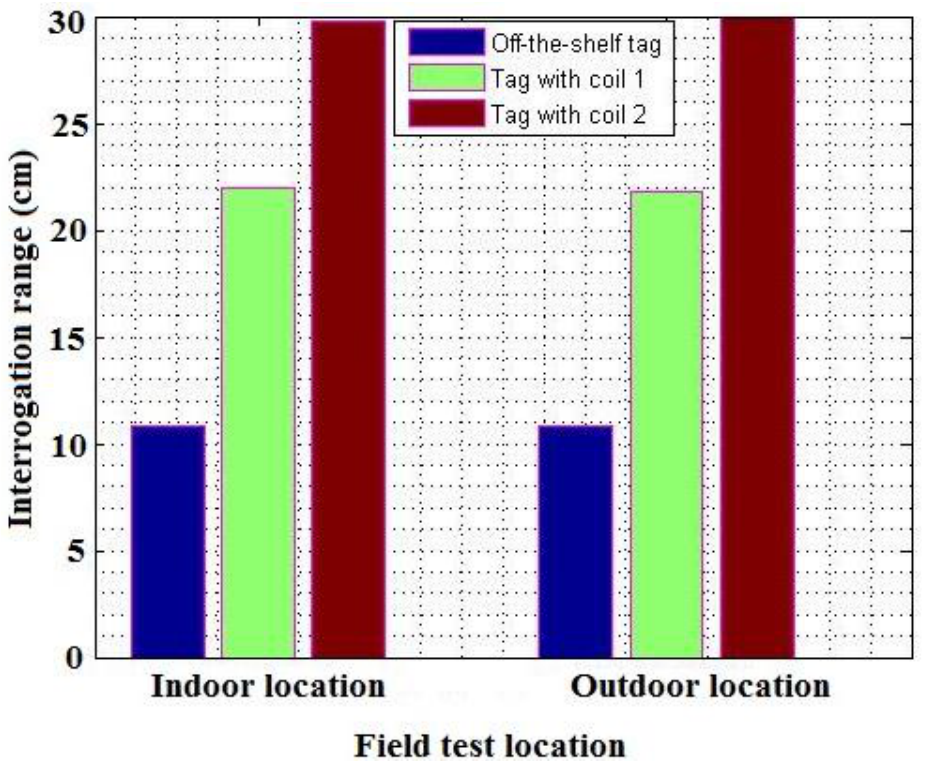
Figure 13. The different interrogation ranges obtained in an indoor and outdoor location.